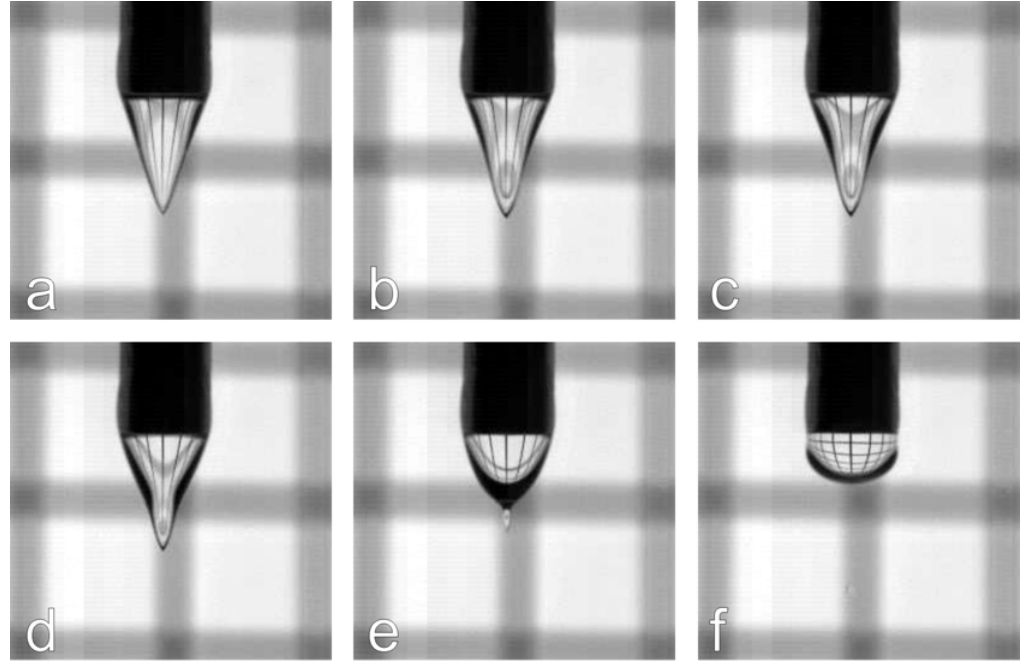
Figure 3. Cone (a) and droplet ejection (b-f) in a water electrospray recorded with a Photron SA-1 high speed camera. Nozzle inner/outer diameter 0.84/1.27 mm diameter; +4.5 kV potential; 1.5cm distance to counter electrode; flow rate 2mL/h; time interval between the images 2 ms (from